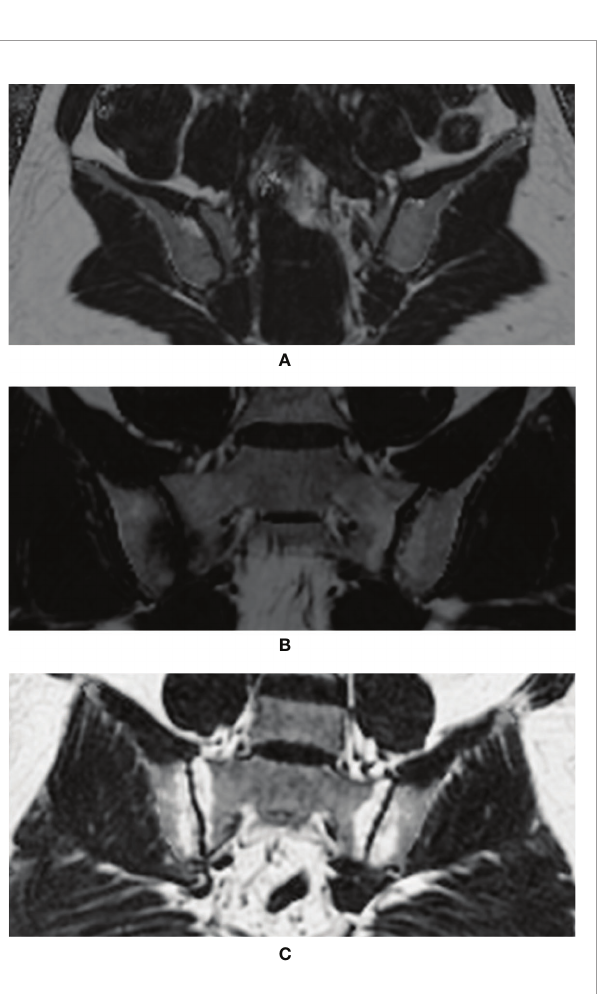
SpA, spondyloarthritis; nr-axSpA, non-radiographic spondyloarthritis; r-axSpA, radiographic spondyloarthritis; bDMARDs, biologic disease-modifying antirheumatic drugs; BASDAI, Bath Ankylosing Spondylitis Disease Activity Index; ASDAS-CRP, Ankylosing Spondylitis Disease Activity Score with C-reactive protein; SPARCC, Spondyloarthritis Research Consortium of Canada; SSS, MRI Sacroiliac Joint Structural Score.